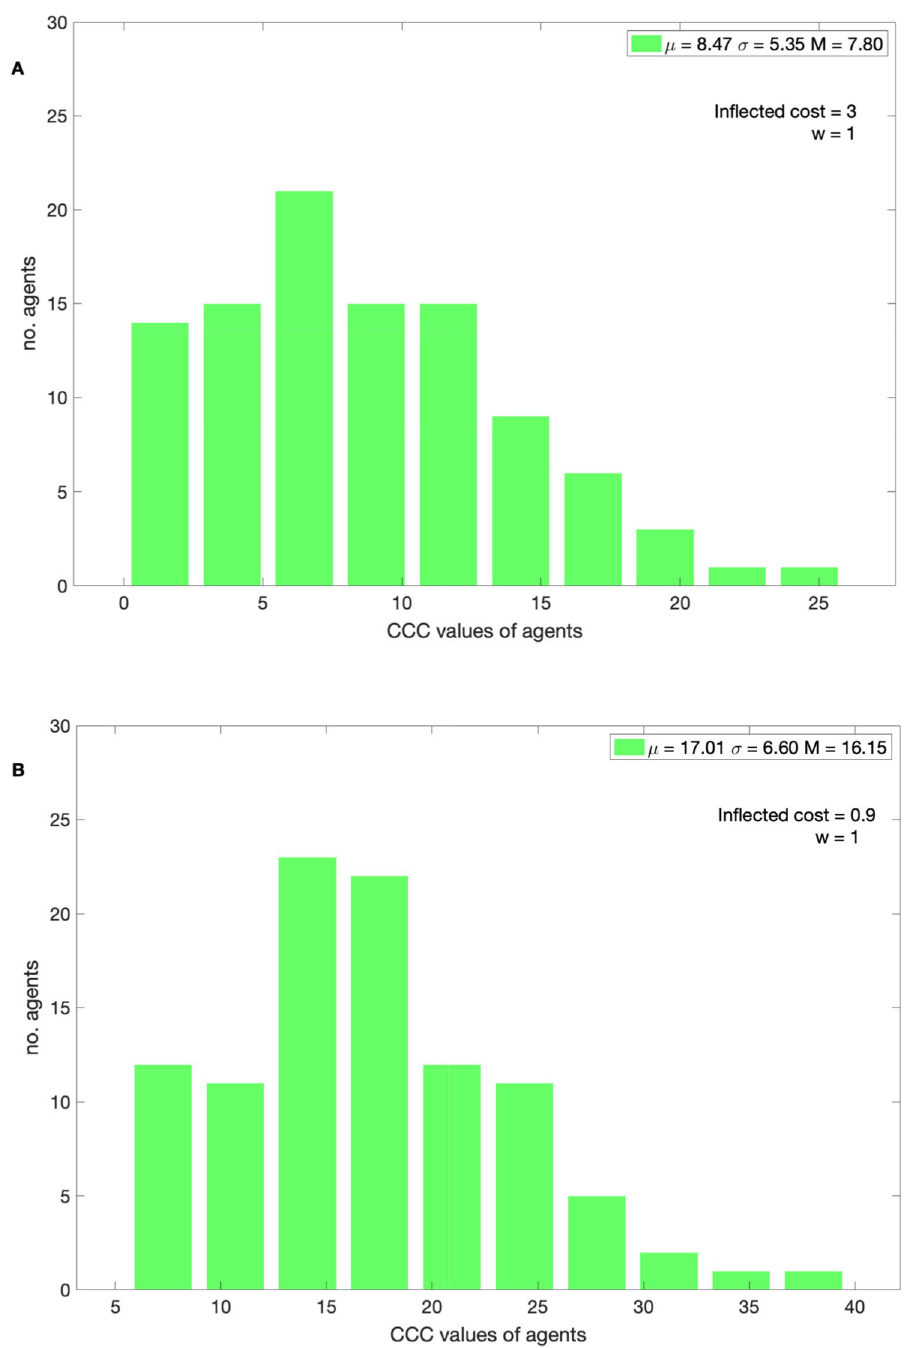
Figure 3. The distribution of CCC values in the 20,000th generation with a bin size of 10. With w = 1 ( A ) (cost) = 3 and with ( B ) (cost) =